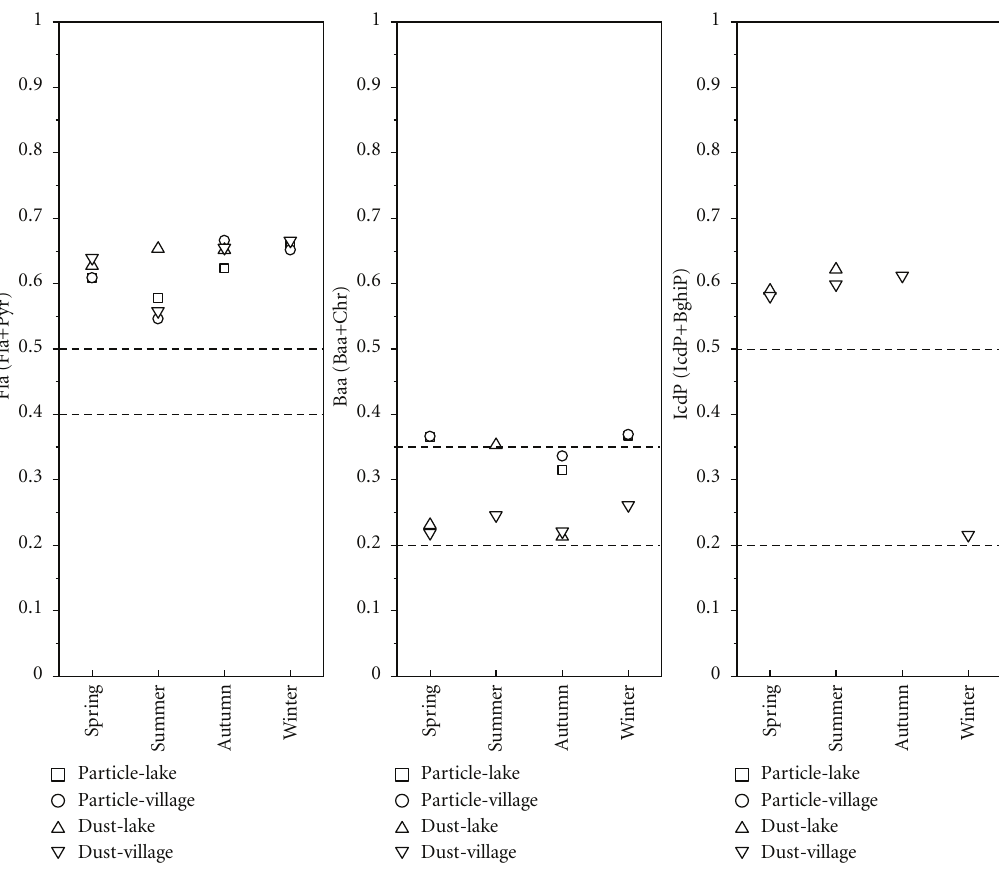
Figure 7: Isomer ratios of (Fla/Fla + Pyr), Baa/(Baa + Chr), and IcdP/(IcdP +